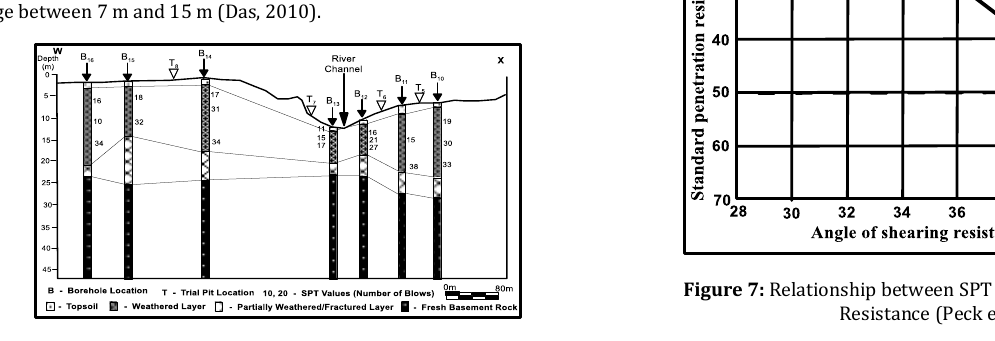
Figure 3: Lithological Section along Dam Axis A